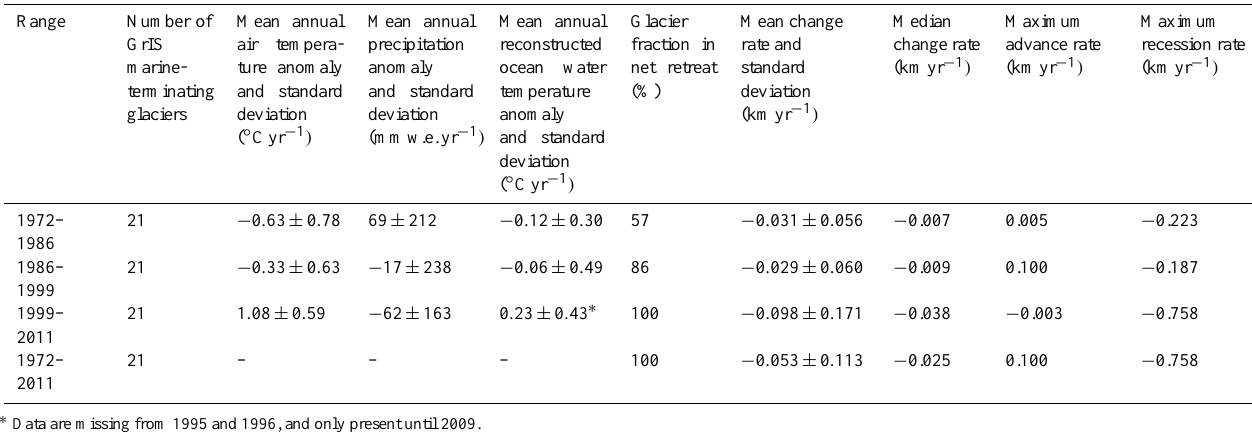
Table 2. Frontal position change rate statistics for the period 1972–2011 for the GrIS marine-terminating glaciers in the Ammassalik region, mean annual air temperature and precipitation anomaly from the DMI meteorological station in Tasiilaq, and mean annual reconstructed